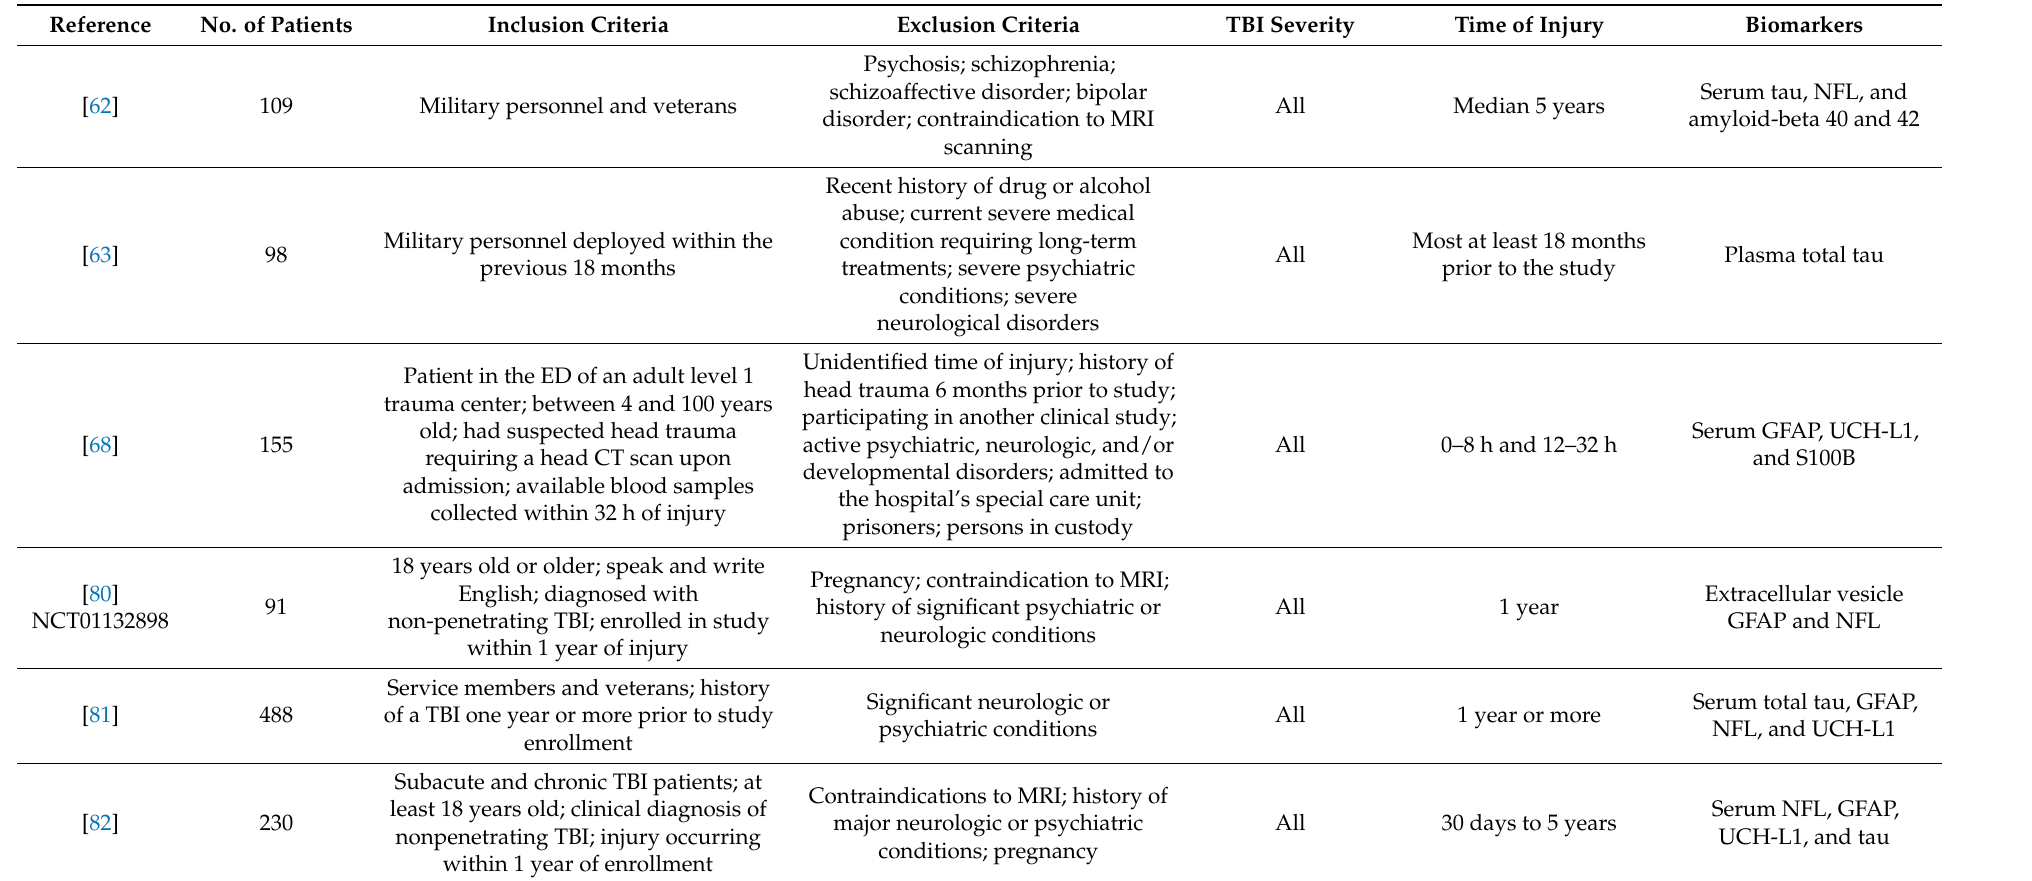
Table A1. Summary of Clinical